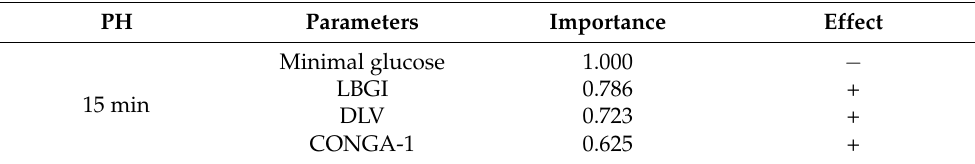
Table 4. The most important NH predictors revealed by RF in patients with